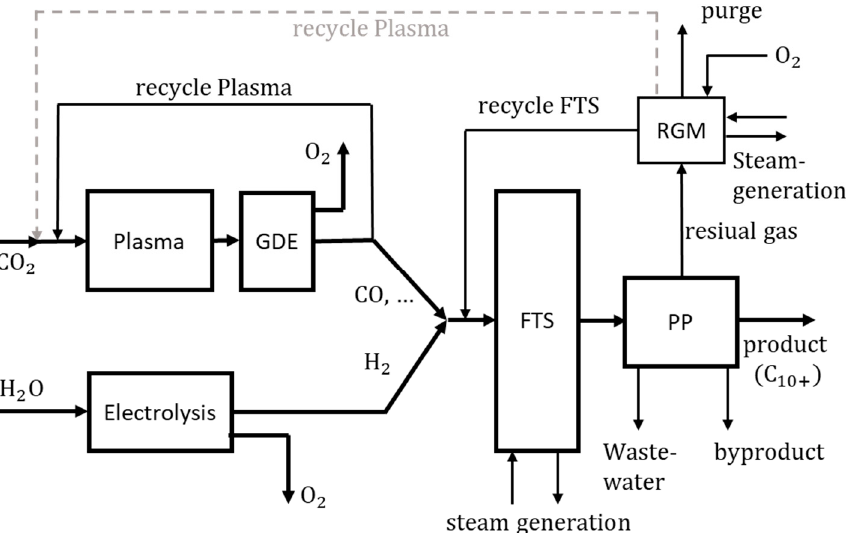
Figure 6. Block flowsheet of the modeled process consisting of the plasma-reactor, gas diffusion electrode (GDE), electrolysis, Fischer–Tropsch synthesis reactor (FTS), product preparation (PP), and residual gas management (RGM).